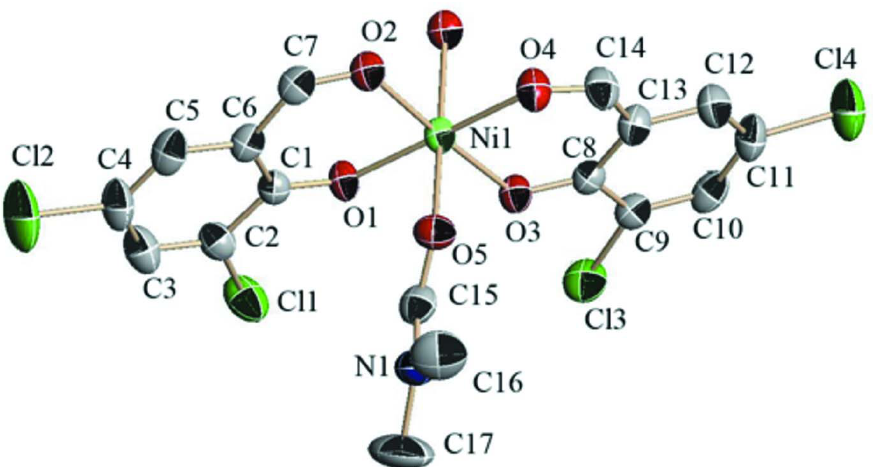
Figure 1 A view of (I), showing 30% probability displacement ellipsoids. Hydrogen atoms are omitted.